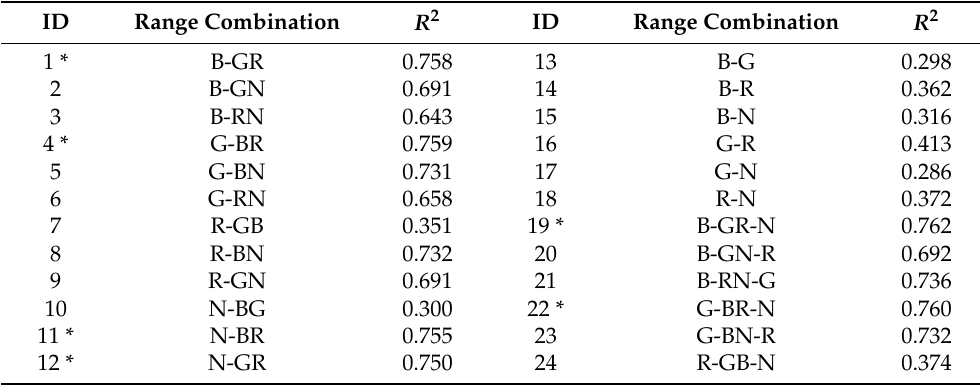
Table 3. Binary and ternary spectral indices combination models and their